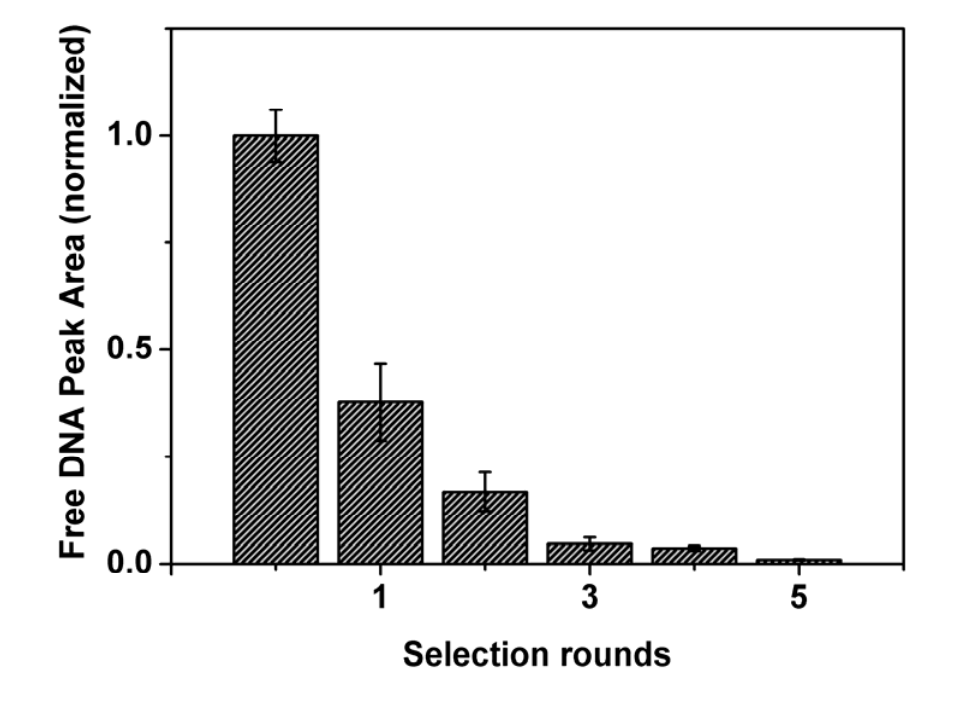
Figure 2. Affinity of the DNA library (first bar) and the enriched DNA pools to lysozyme after each CE-SELEX round. Free DNA peak areas were measured by affinity capillary electrophoresis. Error bars indicate the 95% confidence intervals as determined from non- linear least-squares regression analysis.